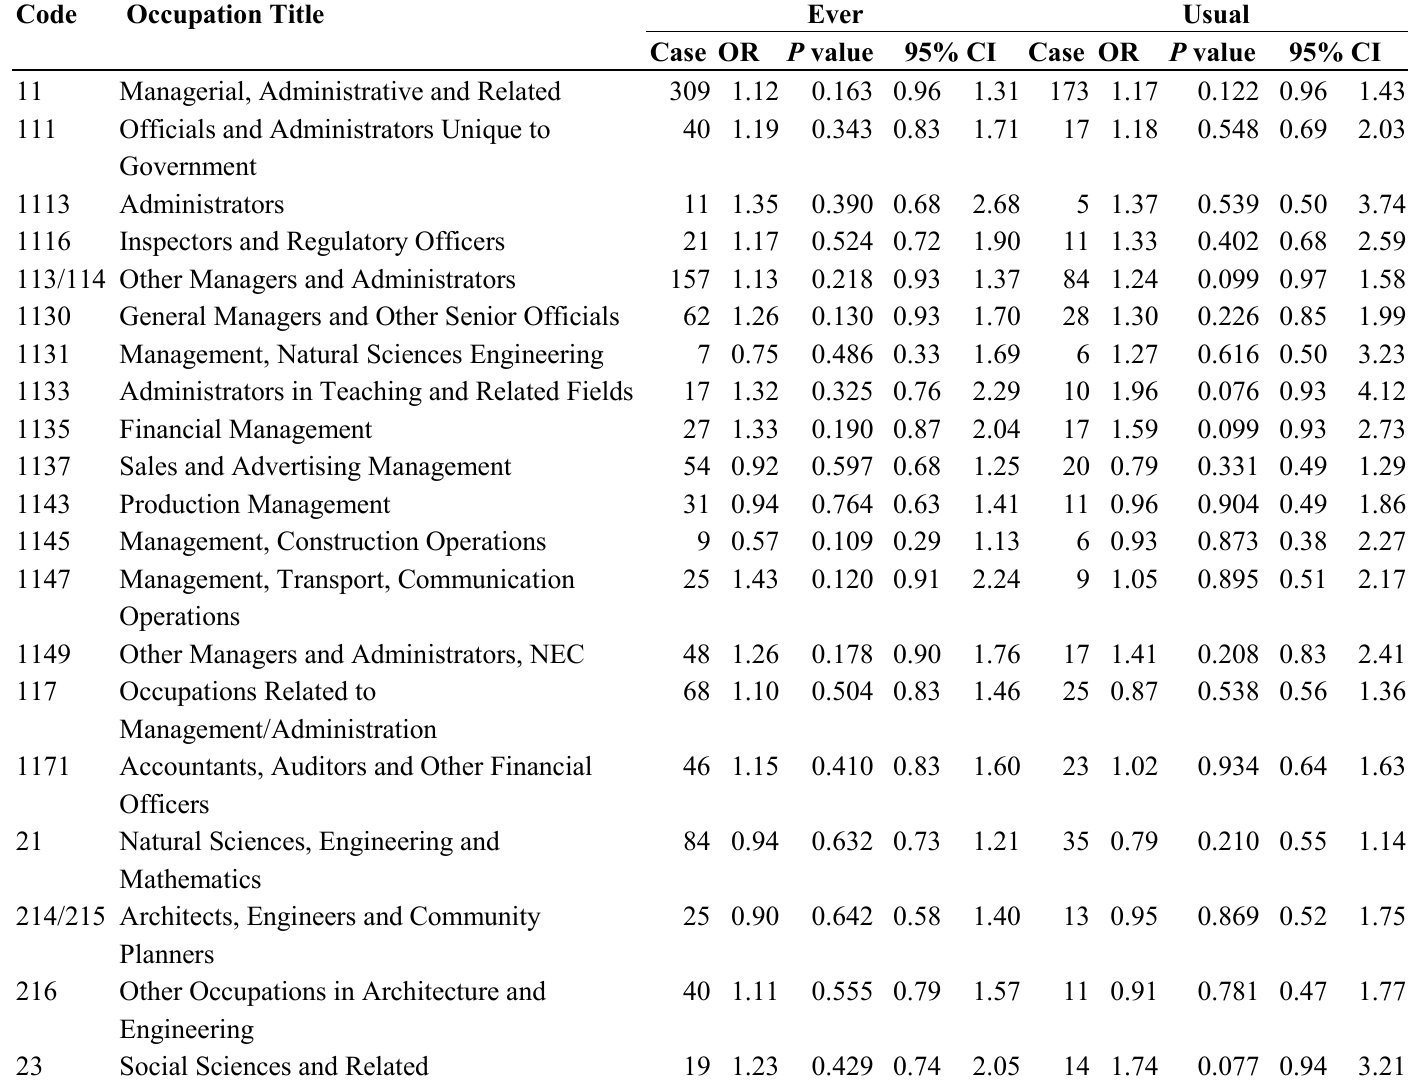
Table 4. Odds Ratios for ever and usual